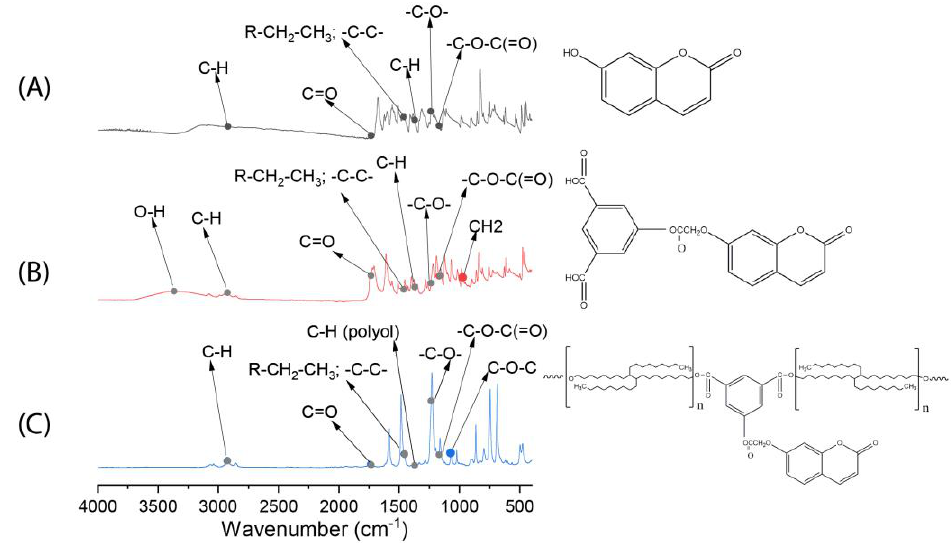
Figure 3. The key FTIR spectra of 7−hydroxy−coumarin ( A ), ICM ( B ), and the final fatty acid dimer ester containing the pendant coumarin group ( C ).